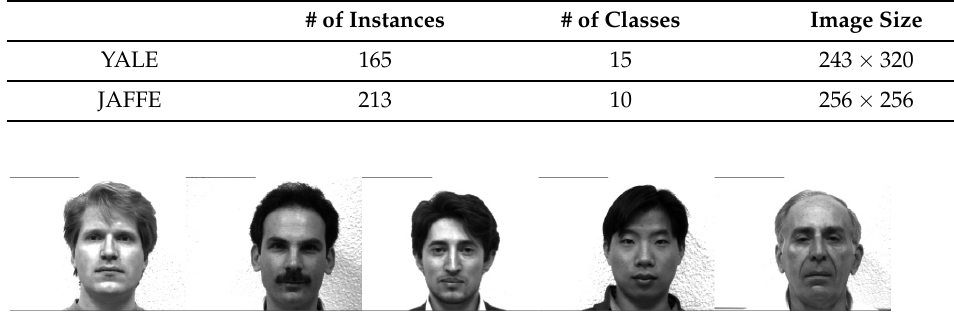
Figure 15. Samples of the Yale Face Database.